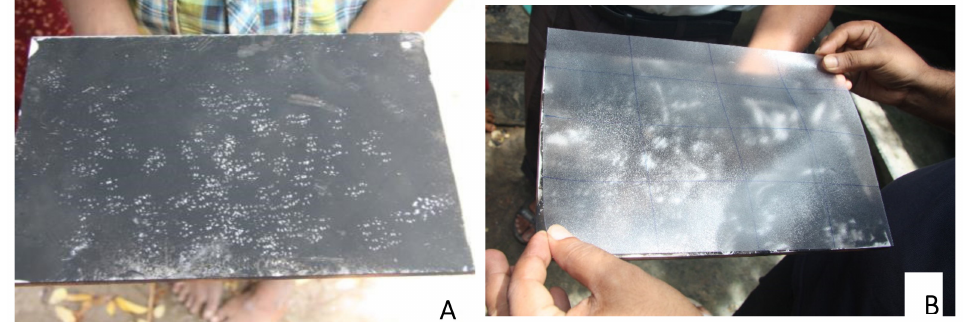
Figure 4. Tracking tiles: ( A ) with rodent footprints; ( B ) determining the percentage area marked by rodent footprints by placing a transparent plastic sheet marked into 16 cells on top of the